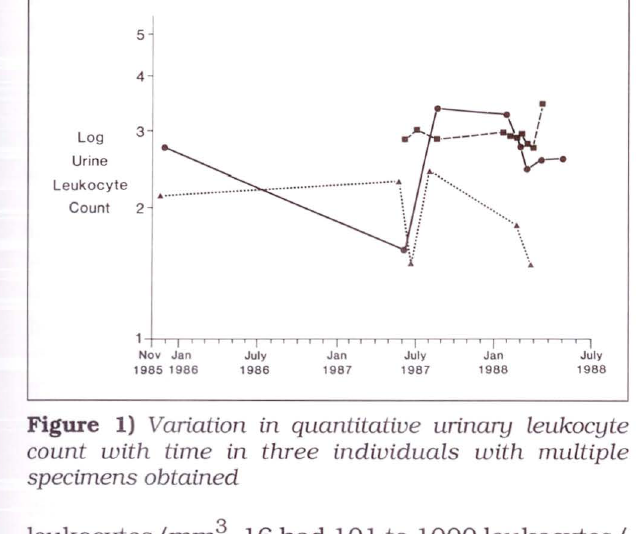
Figure 1) Variation in quantitative urinary leukocyte count with time in three individuals with multiple specimens obtained 3 leukocytes/mm , 16 had 101 to 1000 leukocyi;es/ mm3 leukocytes/mm3 , and one had over 1000